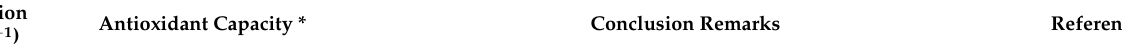
Table 3. The phenolic profile and antioxidant capacity in apple products and apple by-products.